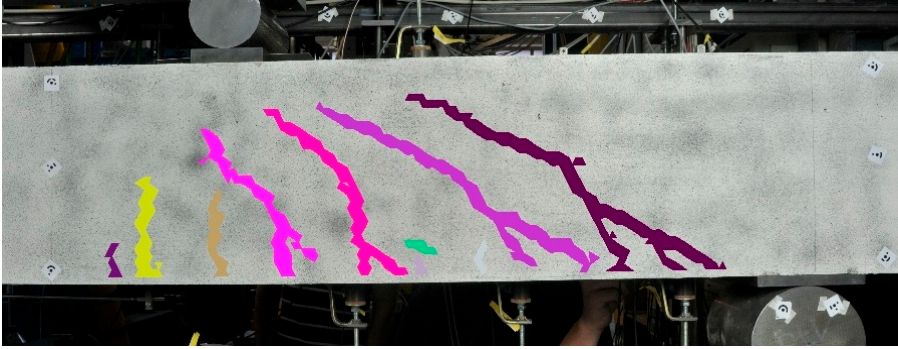
(cid:12) (cid:12)(cid:12) (cid:12) (cid:12)(cid:12) → (cid:12) (cid:12) (cid:12) (cid:12) > δ according to [19]. (cid:12) (cid:12) (cid:12) (cid:12) t rel (cid:12) (cid:12)